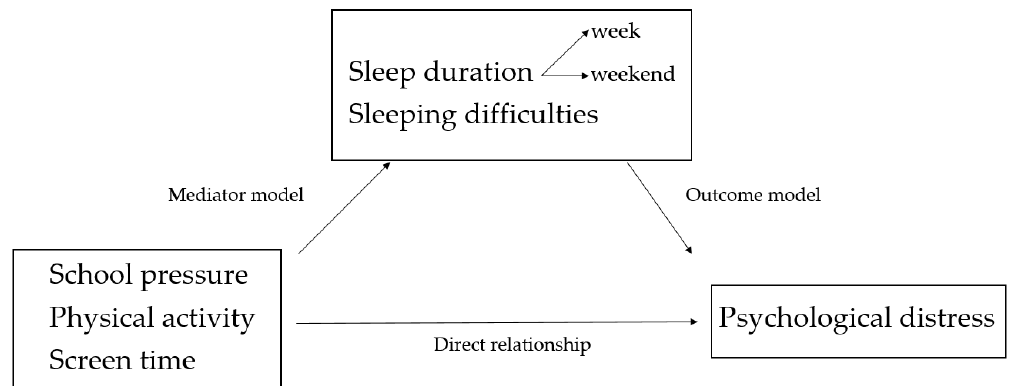
Figure 1. Visual representation of the model tested. It assesses the direct relationship of school pressure, physical activity, and screen time with psychological symptoms and the mediation of this relationship by sleep duration and sleep onset difficulties.